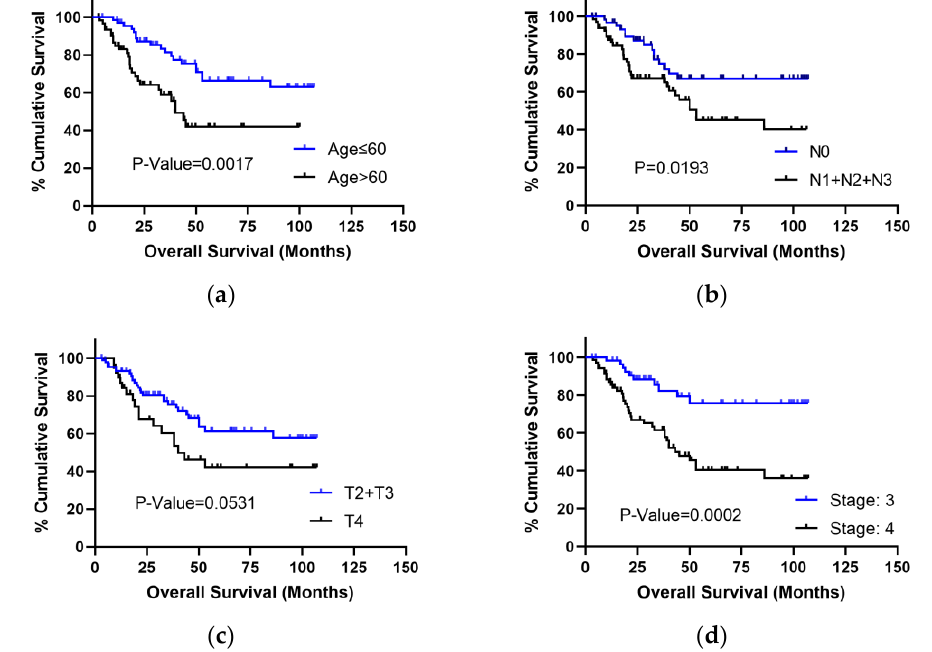
Figure 5. K-M analysis of demographic indicators to predict OS ( p -value < 0.1) in LSCC. ( a ) K-M analysis of age for OS with the log-rank test. ( b ) K-M analysis of N stage for OS with the log-rank test. ( c ) K-M analysis of T stage for OS with the log-rank test. ( d ) K-M analysis of clinical stage for OS with the log-rank